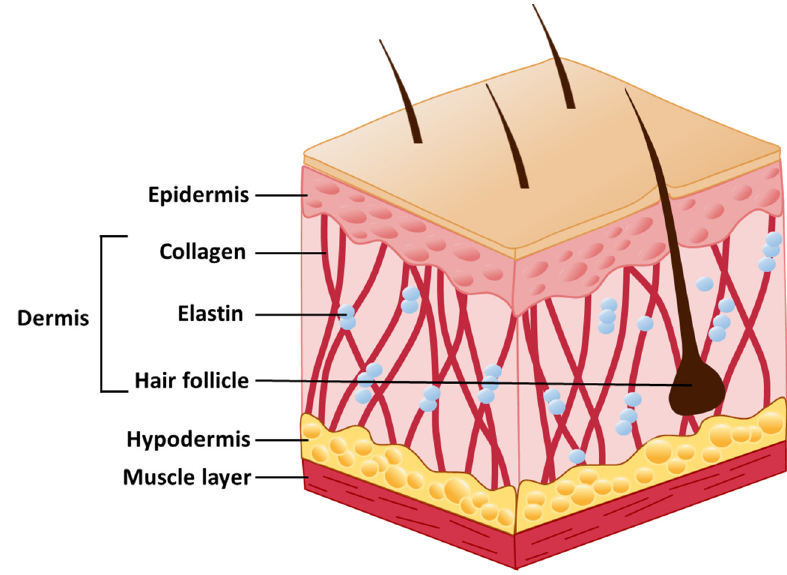
Figure 1. Schematic representation of the human skin structure.